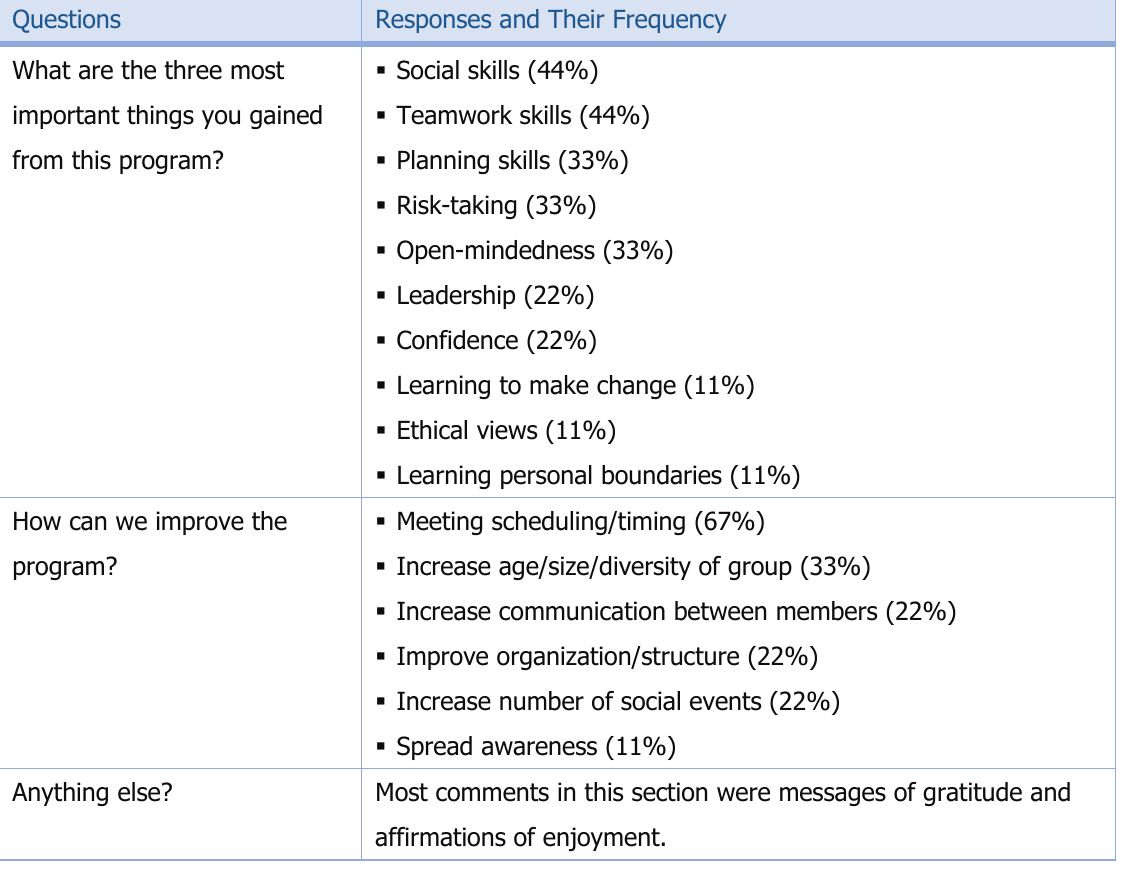
Table 2: Open-Ended Survey Question Responses and their Frequencies